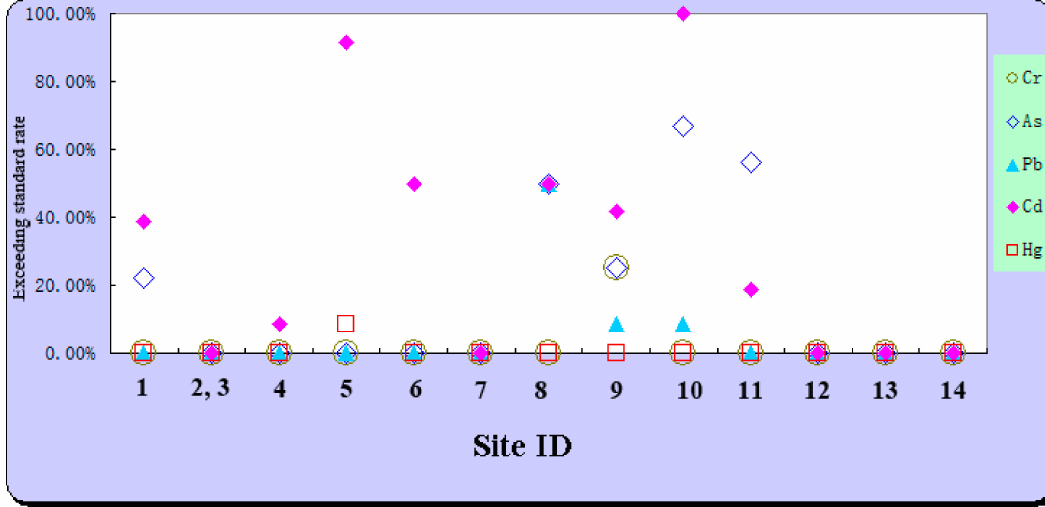
Figure 2. Exceeding the standard rate of arsenic and heavy metals in